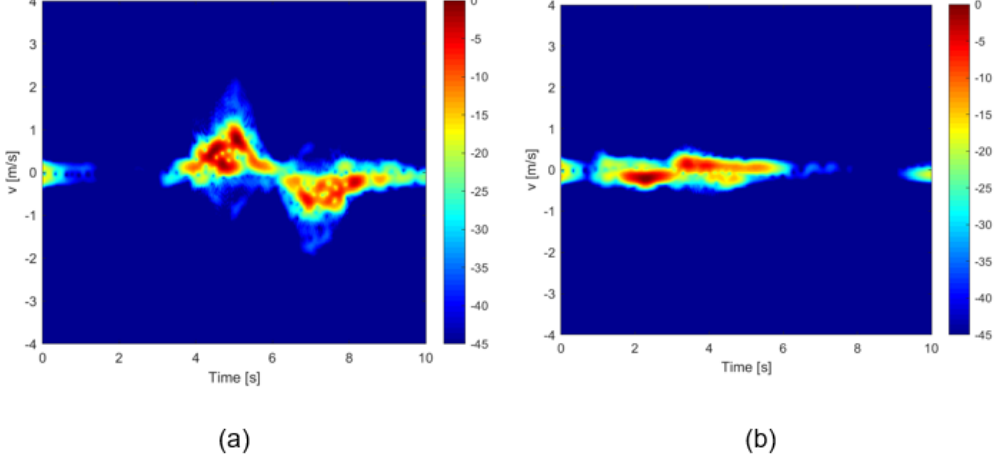
Figure 15. ( a ) Micro-Doppler spectrograms of activity 4 and ( b ) activity